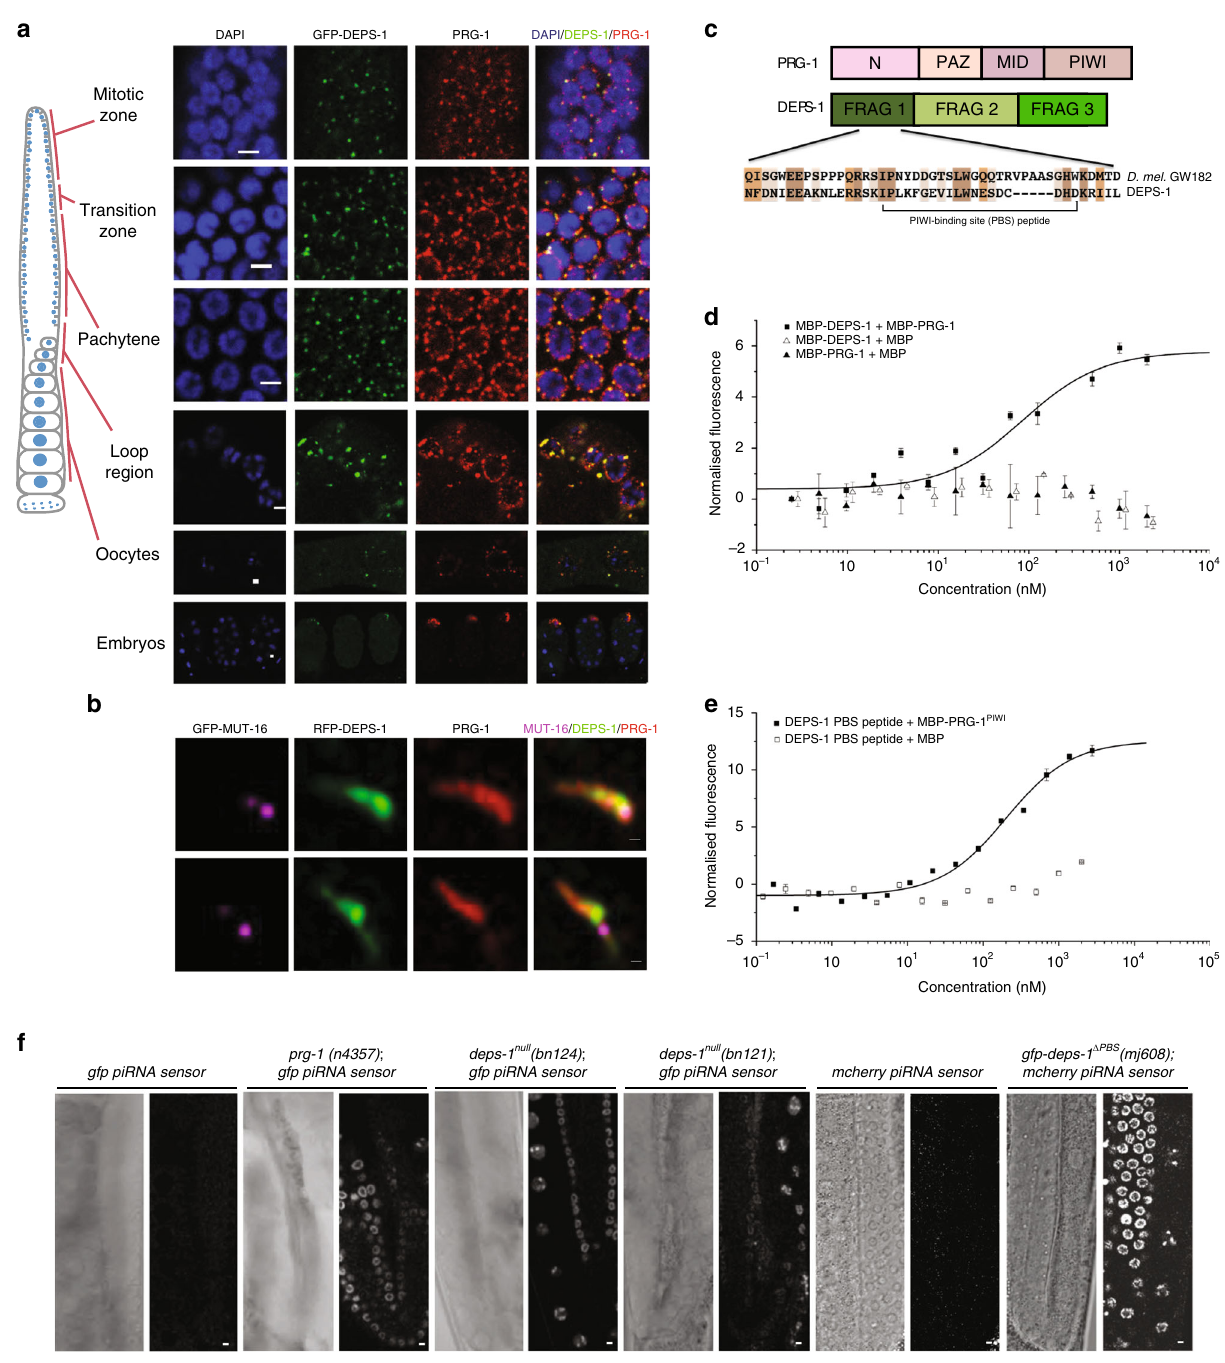
Fig. 1 DEPS-1 binds to PRG-1 and mediates piRNA-dependent transgene silencing. a DEPS-1 and PRG-1 colocalise as peri-nuclear granules. C. elegans germlines expressing GFP-DEPS-1 were dissected and immunostained for GFP and PRG-1. PRG-1 and DEPS-1 colocalise in the proliferative zone, transition zone, pachytene, oocytes and embryos. A higher proportion of PRG-1 remains perinuclear in the loop region compared to DEPS-1. Scale bar = 3 µ m. b Colocalisation of PRG-1, DEPS-1 and MUT-16. Dissected germlines co-stained for PRG-1, RFP-DEPS-1 and GFP-MUT-16 were imaged and deconvoluted with HyVolution settings. Two clusters with all three proteins present are shown. Scale bar = 0.25 µ m. c Domain/fragment architecture of PRG-1 and